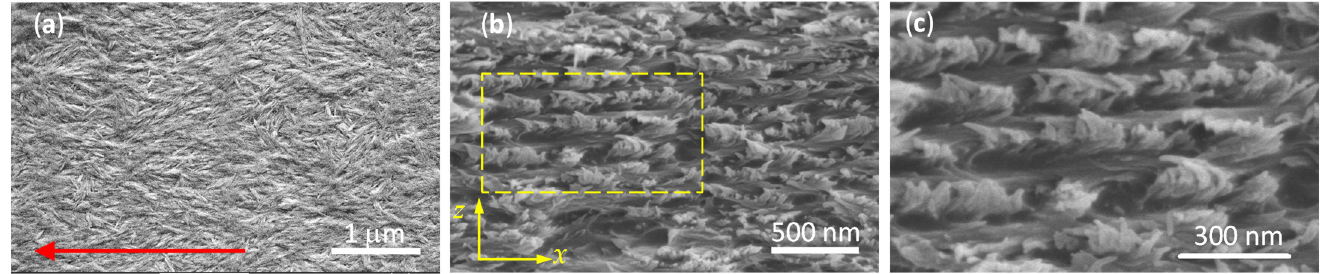
Figure 4. SEM images of shear-coated CNC films: ( a ) the surface of a film prepared on day 1; the arrow indicates the direction of the applied shear. ( b ) Cross section of a film prepared from a suspension stored for 38 days. ( c ) Magnification of the highlighted area in ( b ).